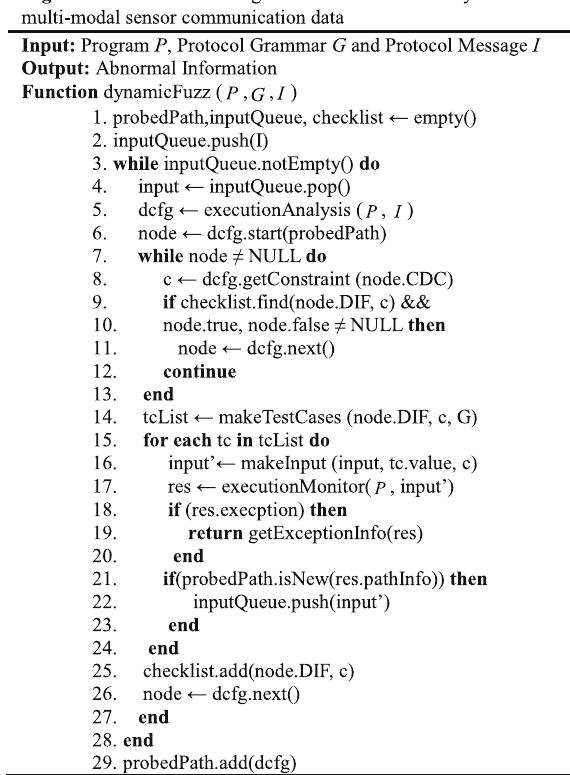
algorithm will skip the test case generation of the node directly. Line 29 of algorithm stores the dynamic control flow diagrams as the paths probed in the queue after com- pleting the code paths of